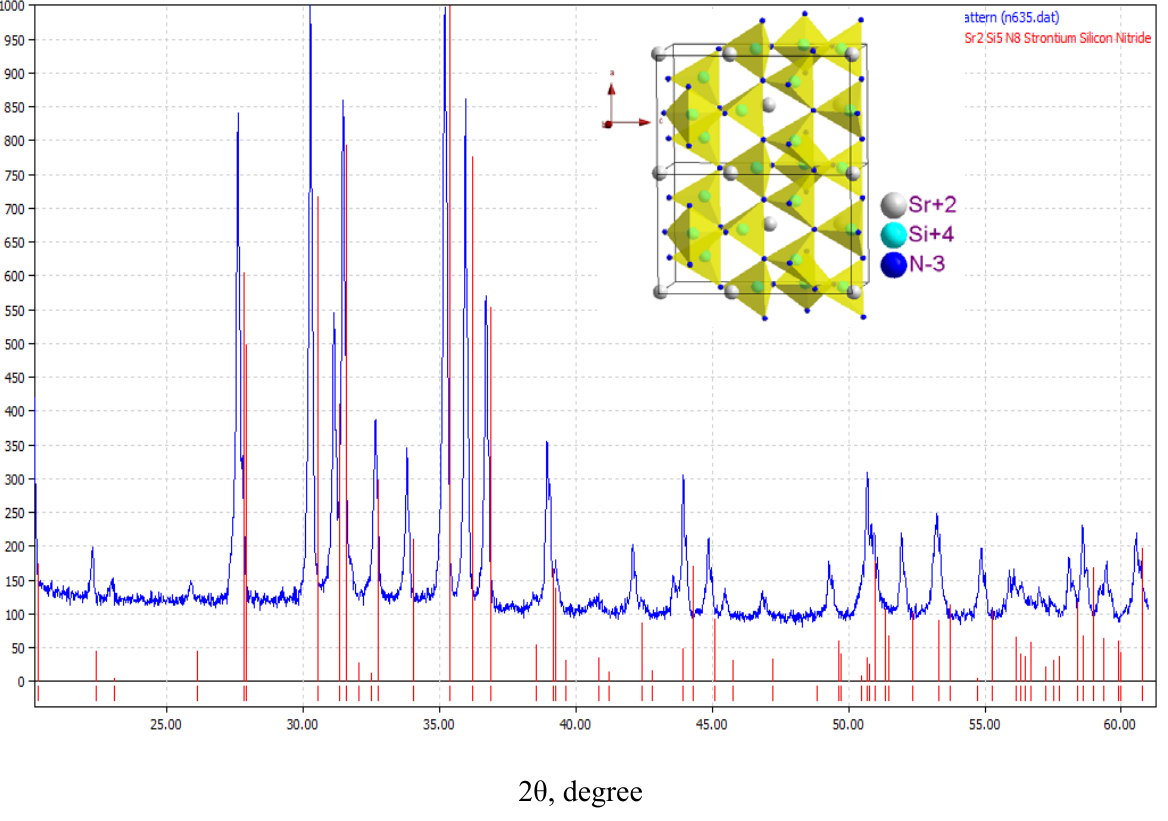
Ba Eu ) Si N . Inset presents its 0.82 0.15 0.03 2 5 8